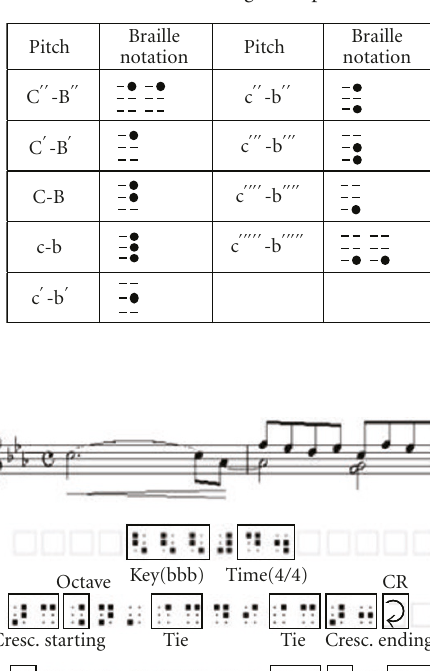
Table 1: Octave signs for pitch.